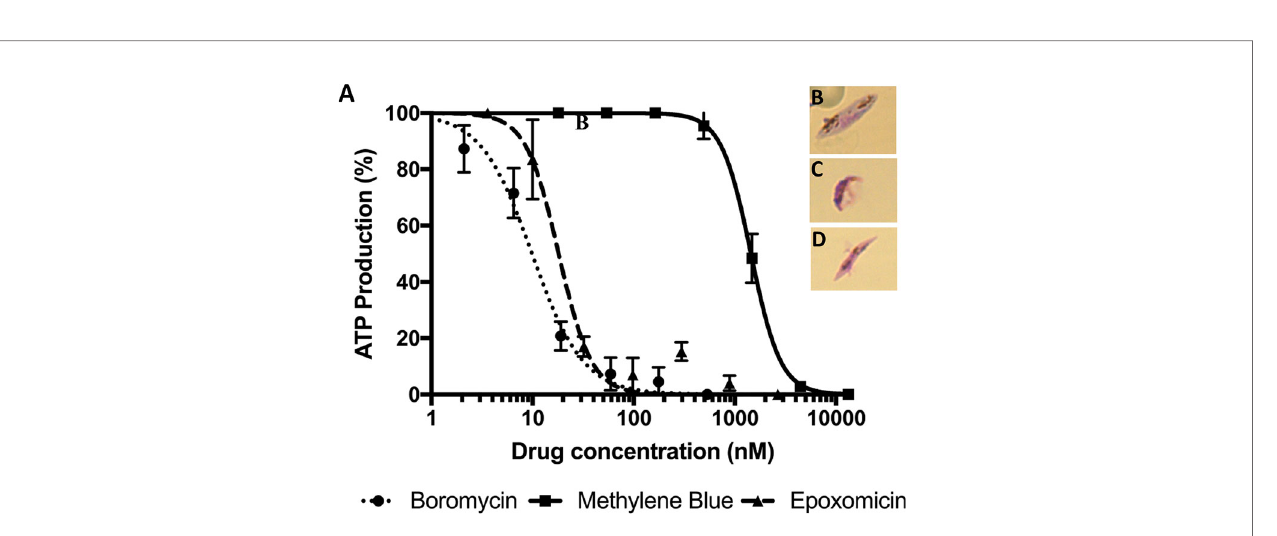
FIGURE 4 | Activity of boromycin, and the positive controls epoxomicin and methylene blue against mature (stage IV-V) P. falciparum gametocytes treated for 48 h. (A) Boromycin showed a more potent activity than methylene blue and similar activity to epoxomicin. (B) Untreated mature gametocytes. (C) Boromycin-treated gametocytes and (D) epoxomicin-treated parasites. All experiments were done at least 3 times in